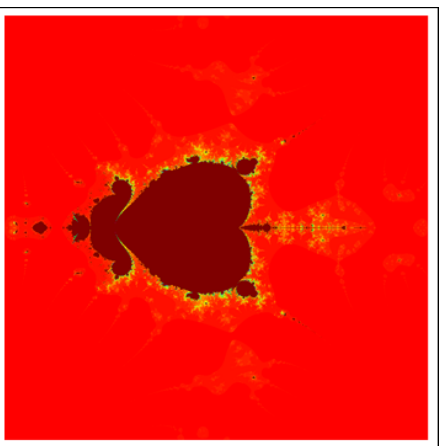
Figure 36. M-set via F-iterative scheme for sin ( z 2 ) + c with image visual time = 176.9.6 s.